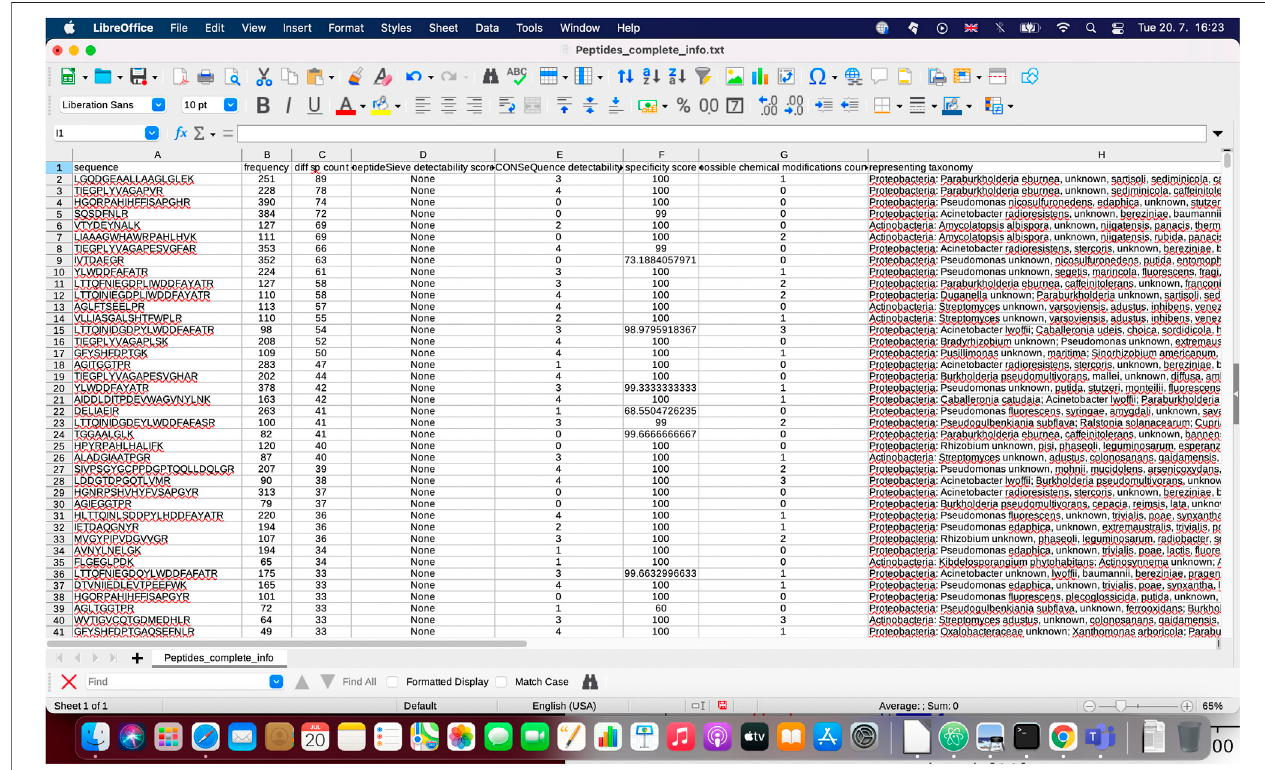
FIGURE 4 | Demonstration of ‘ Peptides_complete_info.txt ’ fi le which provides comprehensive information about peptide properties calculated during the execution of PepMANDIS.